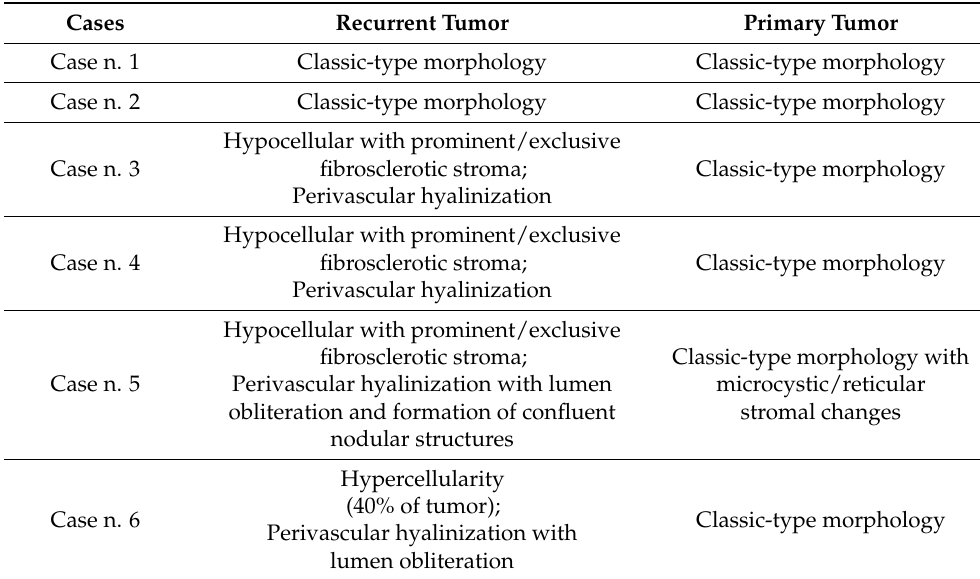
Table 2. Morphological features of recurrent DAMS.